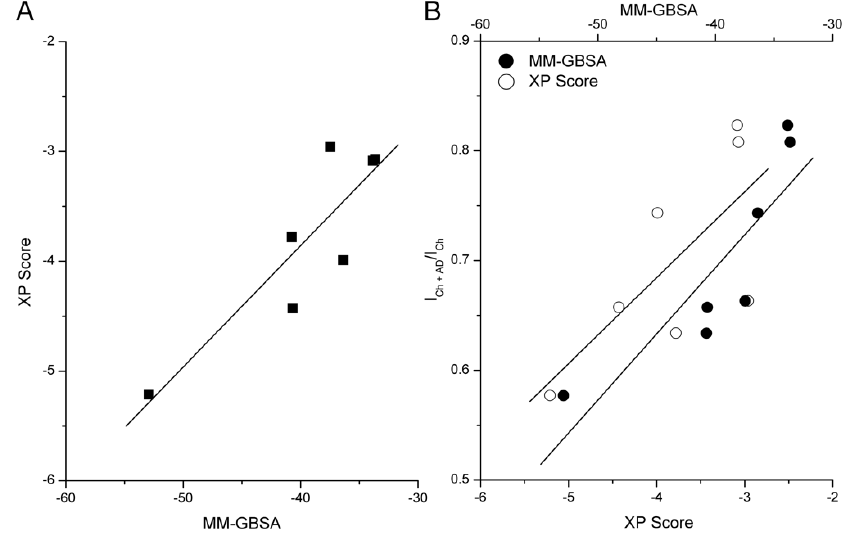
Figure 7. Correlation between molecular docking XP score and MM-GBSA values ( A ). Correlations between the biological activity and both the docking XP score and MM-GBSA ( B ). Data were fitted using a linear regression.